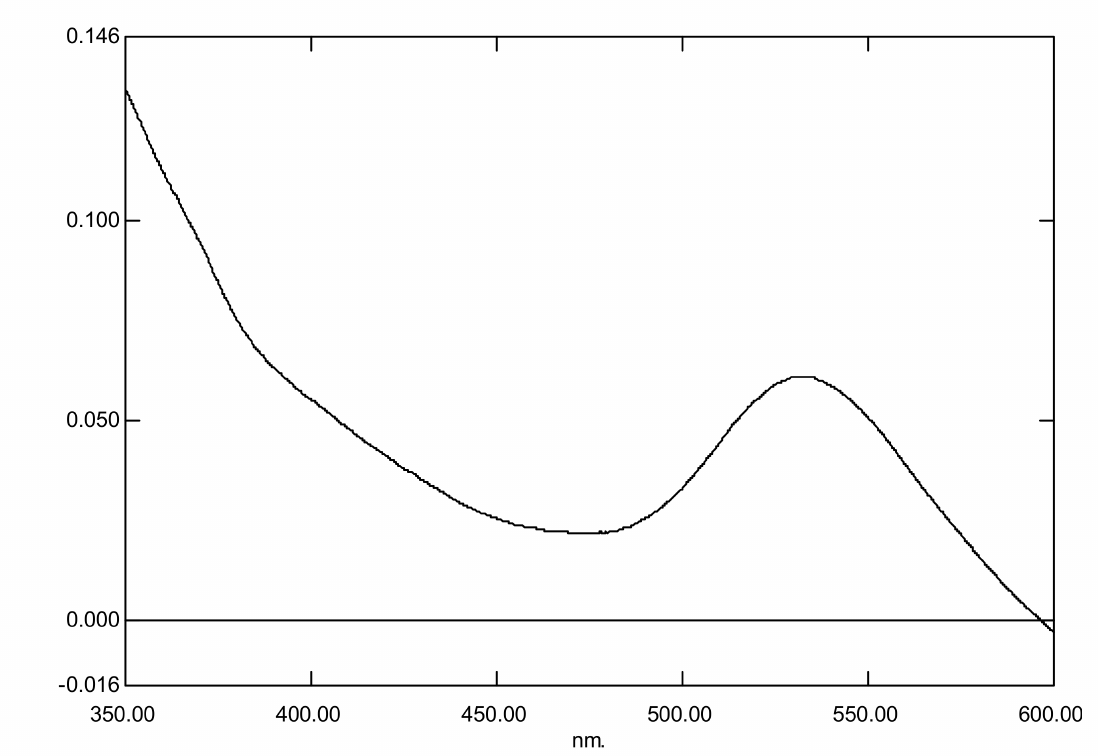
Figure 1. Ultra violet-visible spectrum of